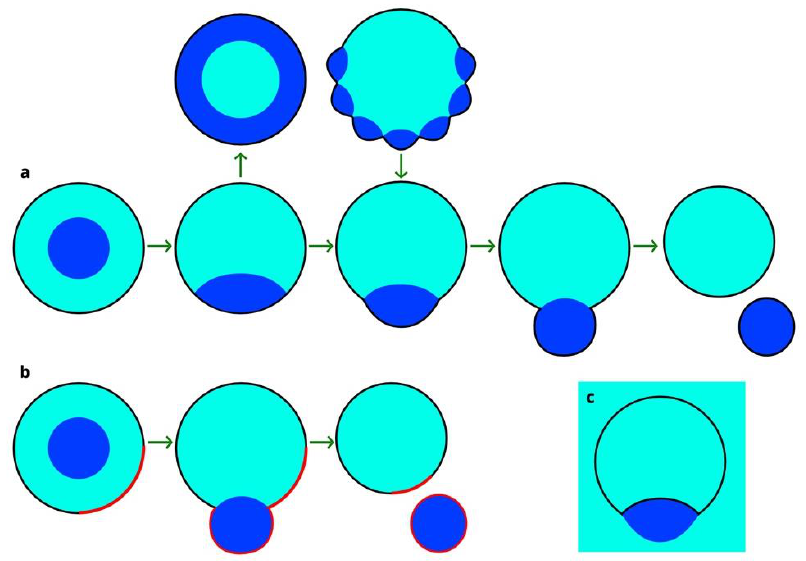
Figure 2. ( a ) Wetting transition leading to inversion of liquid phases (first branch) or budding. Budding may eventually lead to vesicle fission. “Raspberries” of smaller droplets (second branch) may form during dehydration, eventually coalescing into a single bud; ( b ) In the presence of a heterogeneous membrane, the “red” lipid phase has an affinity for the dark blue liquid phase, and the two bud and separate from the mother vesicle together; ( c ) “Inward” budding induced by a dark blue liquid droplet external to the vesicle. Light and dark blue represent liquid phases of an ATPS (e.g., a PEG-rich and dextran rich phase), black the lipid bilayer.